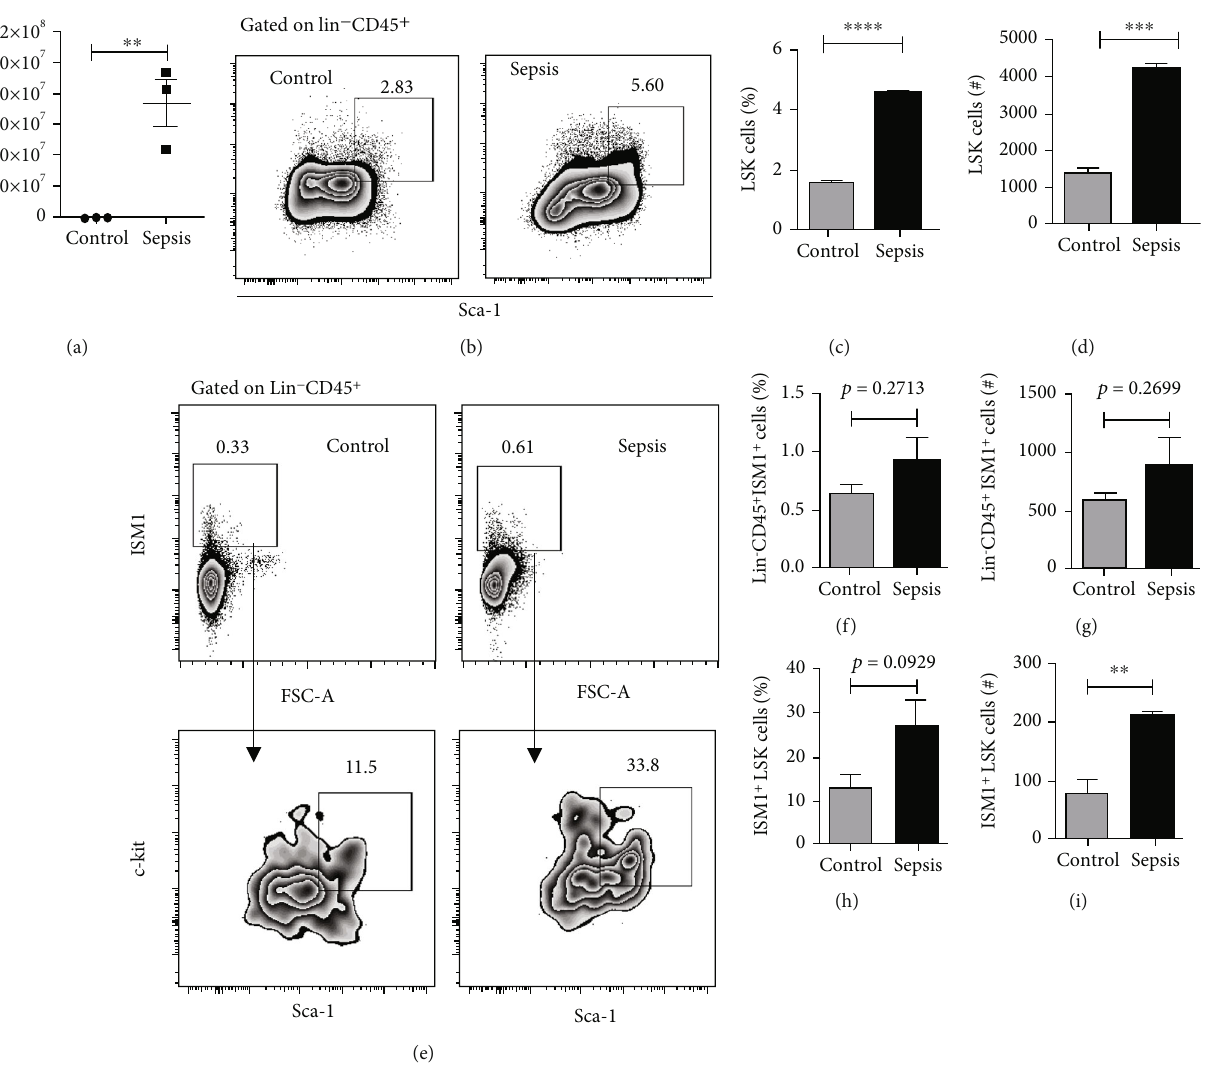
Figure 6: Changes in LSK and ISM1 + LSK cell subsets after P. aeruginosa challenge. (a) CFU from lung tissues after P. aeruginosa infection. (b) LKS cells (Lineage-CD45 + c-kit + Sca-1 + ) from control and septic mice were analyzed, and percentages (c) and absolute numbers (d) are depicted. (e) ISM1 + LSK cells were analyzed, and percentages and absolute numbers are depicted (f – i). Data are means plus SEM n = 3 independent experiments. Statistical analysis was performed by Student ’ s t -test for unpaired data, ∗∗ p < 0 : 01 , ∗∗∗ p < 0 : 001 , ∗∗∗∗ p < 0 : 0001